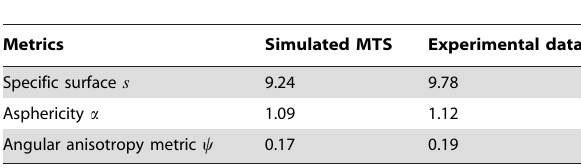
Table 2. Comparison of tumor morphology metrics associated with simulated MTS and experimental data at 24 hours after tumor